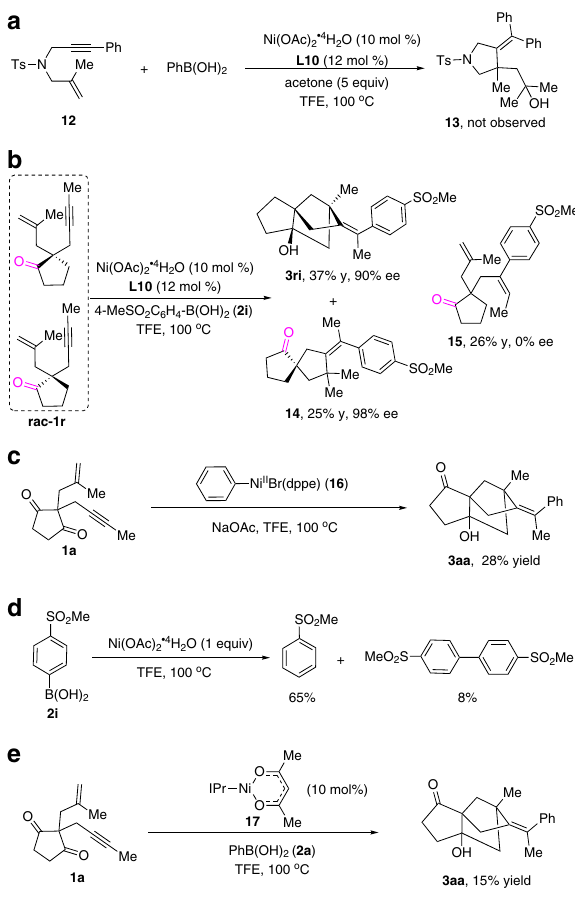
Fig. 6 Mechanistic studies. a Three-component reaction with acetone. b The domino reaction used mono-carbonyl enyne substrate. c The use of stoichiometric aryl-Ni(II) complex in the reaction. d The stoichiometric reaction of Ni(OAc) 2 .4H 2 O with boronic acid. e The use of Ni(I) complex in the